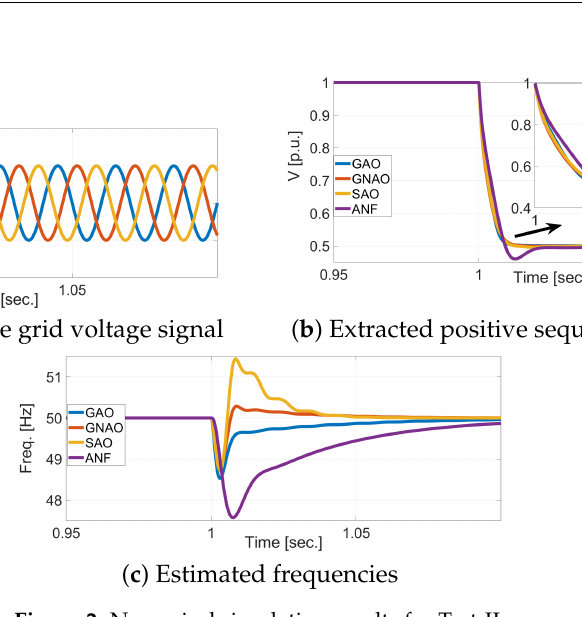
Figure 2. Numerical simulation results for Test-II.